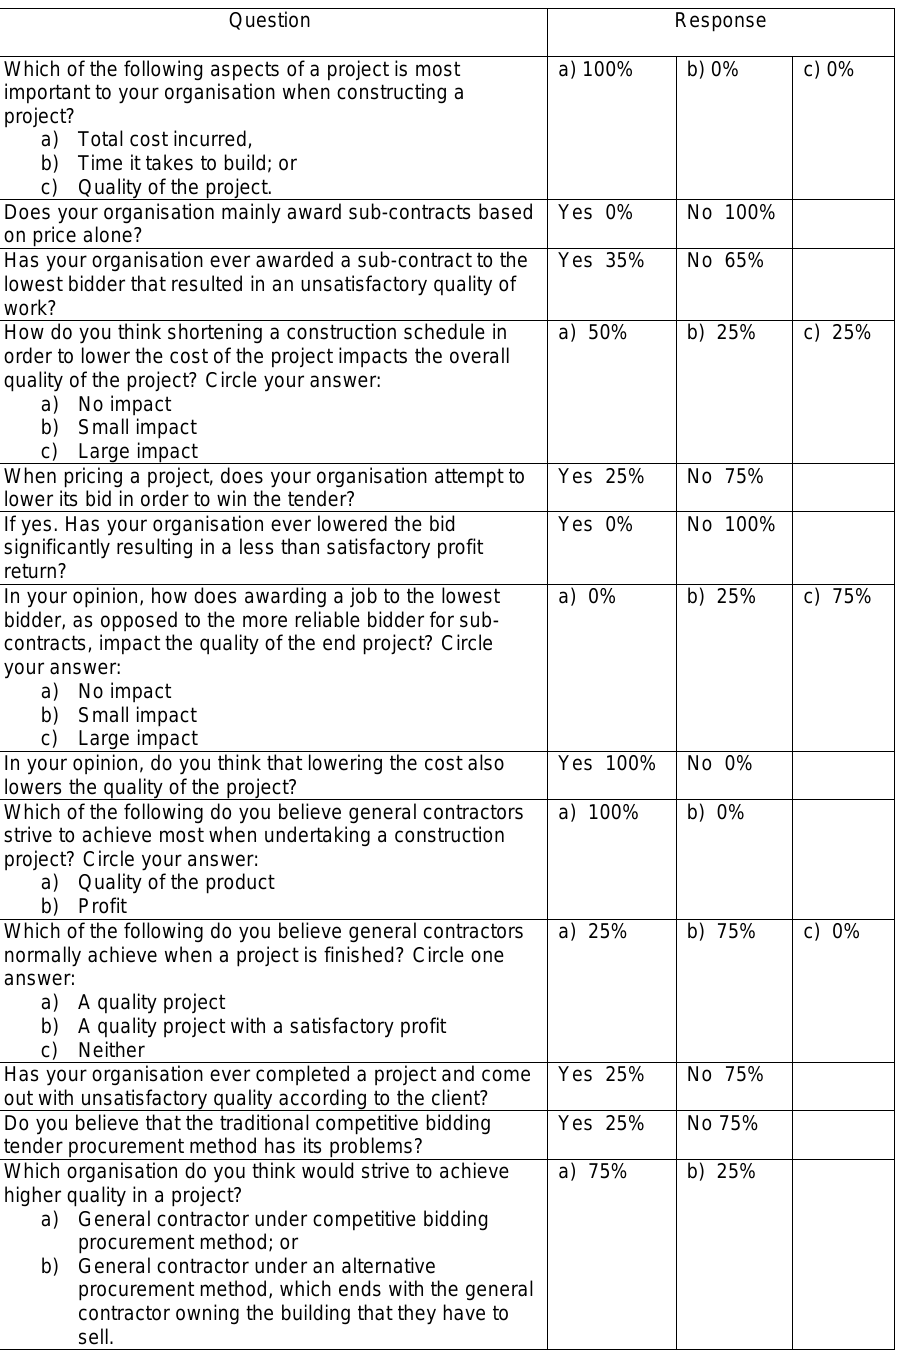
Table 1: Responses to